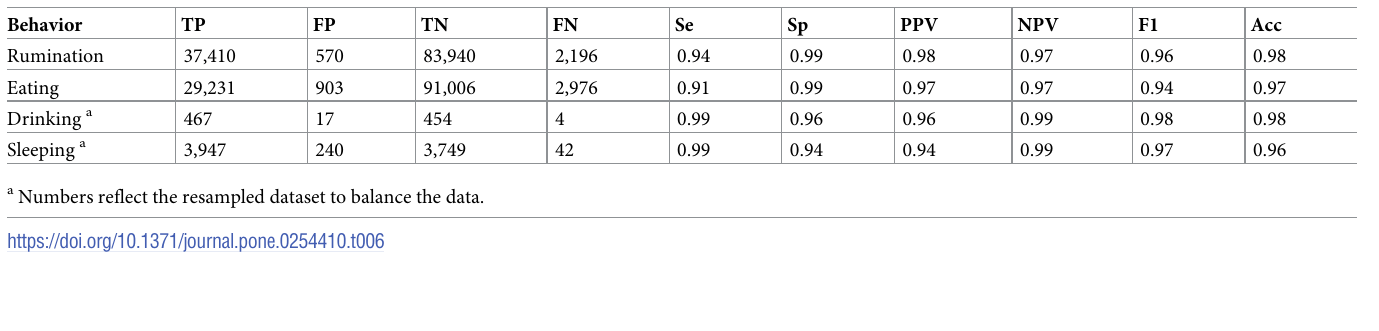
RF, Random Forest; SCV, Five-fold Stratified Cross Validation; LOOA, Leave-out-one-animal based on four cows. a Average and standard variation over 5 folds. b Average and standard deviation over four cows.